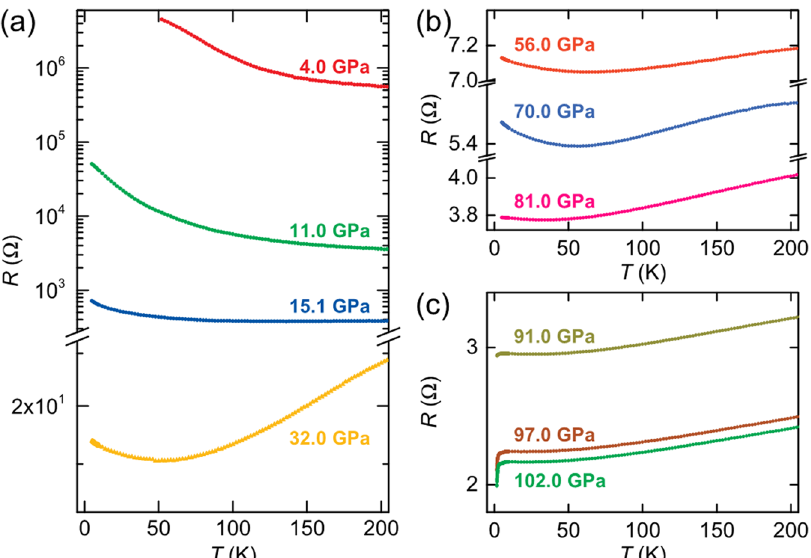
Fig. 5 The temperature dependence of the in-plane electric resistance of ReS 2 at different pressures. In-plane resistance as a function of temperature in ReS